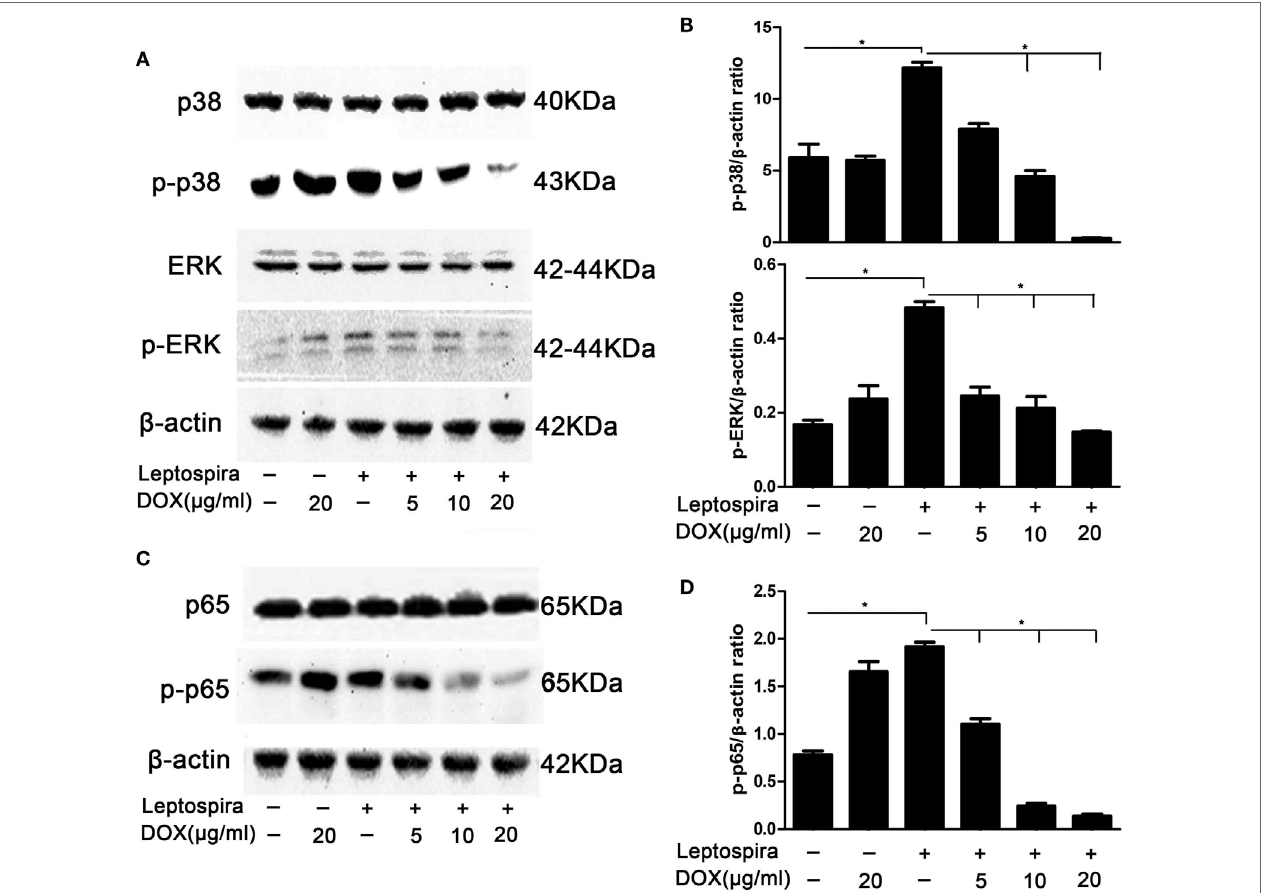
FigUre 2 | Doxycycline (Dox) inhibited the activation of MAPK and NF- κ B pathways in sonicated leptospira-infected J774A.1 cells. J774A.1 cells were seeded at 10 6 cells in six-well culture plates and macrophages were incubated in the presence or absence of various concentrations of Dox added 24 h prior to 10 8 sonicated leptospira infection. The cells were washed in culture medium and incubated for another 24 h with sonicated leptospira alone or with added various concentrations of Dox. After that, the total proteins of cells were extracted and analyzed by western blot with specific antibodies. The β -Actin protein was used as a control. The activation of MAPK (a) and NF- κ B (c) pathways was detected by immunoblot. The gray value of p-p38, p-ERK (B) , and p-p65 (D) was procured using Image-Pro Plus 6.0 software. Each column shows the mean ± SD of three independent experiments and analyzed by the one-way ANOVA. * p <